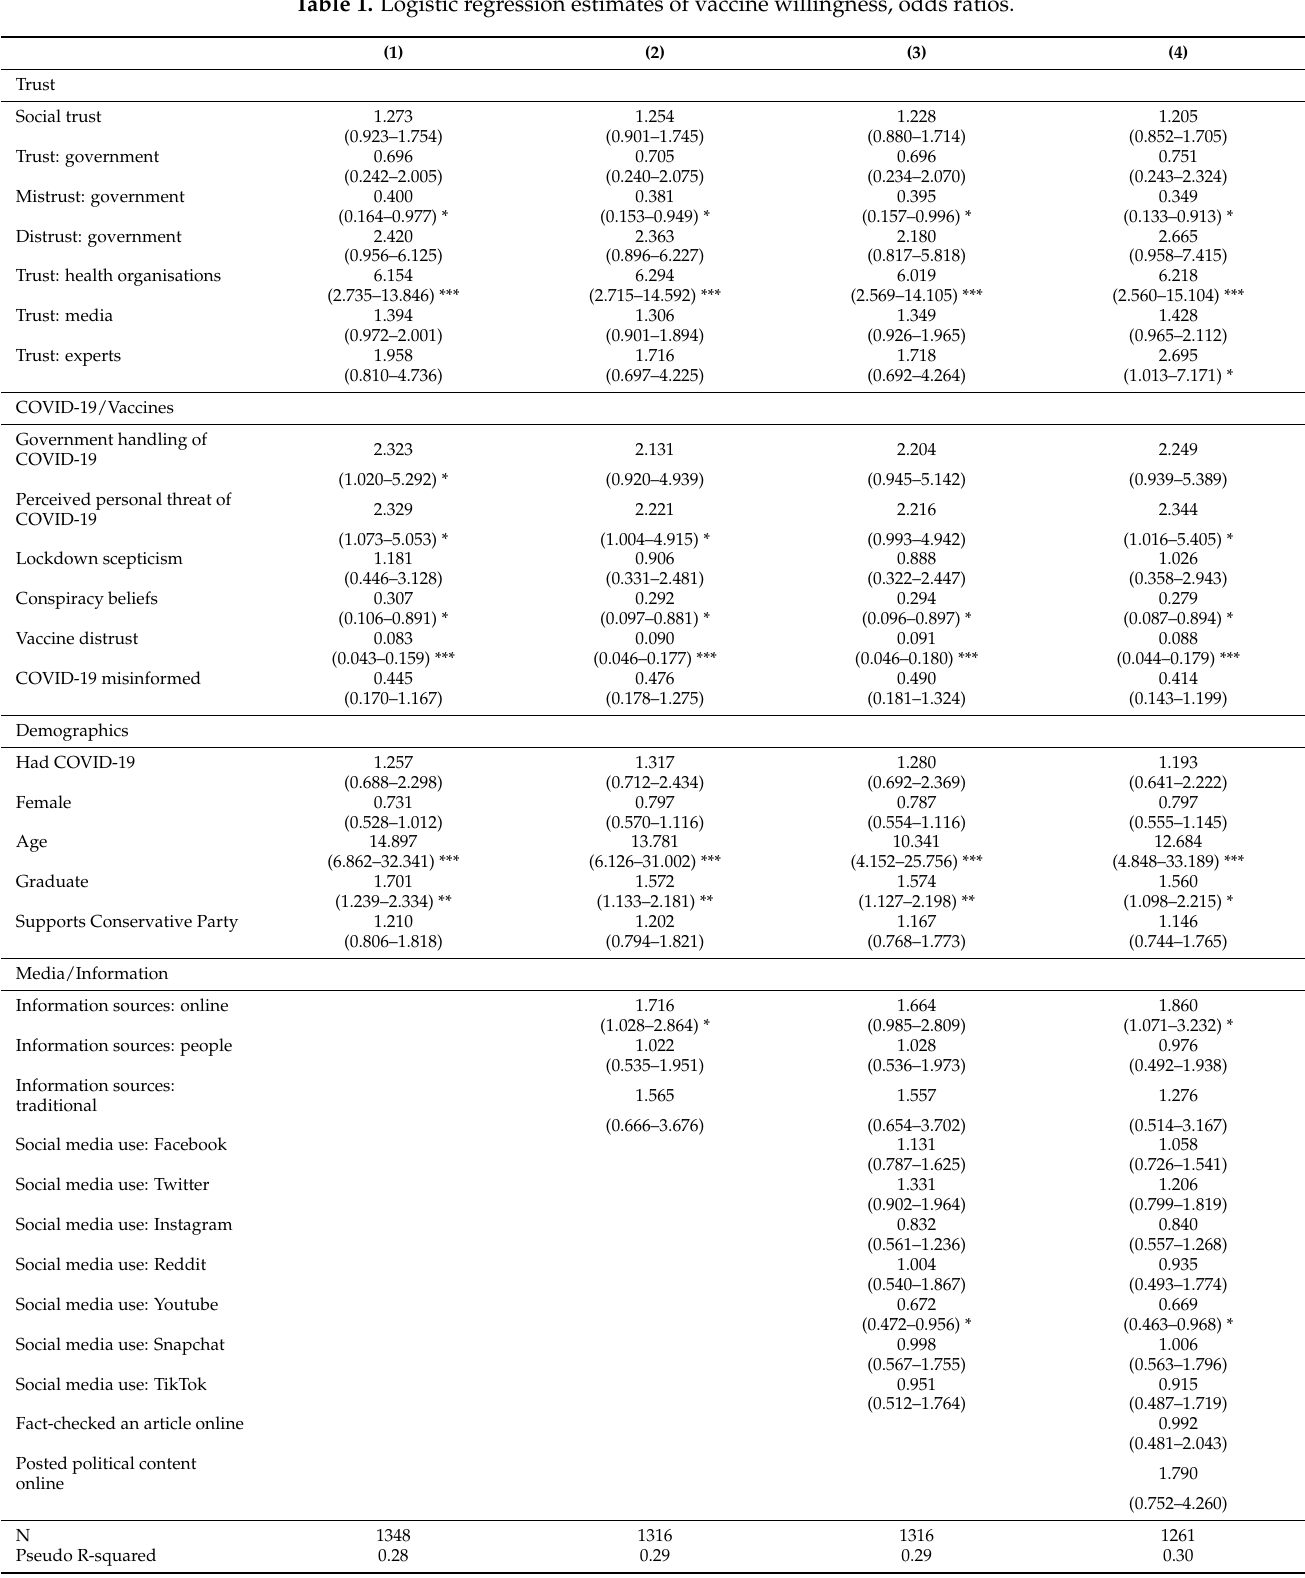
Table 1. Logistic regression estimates of vaccine willingness, odds